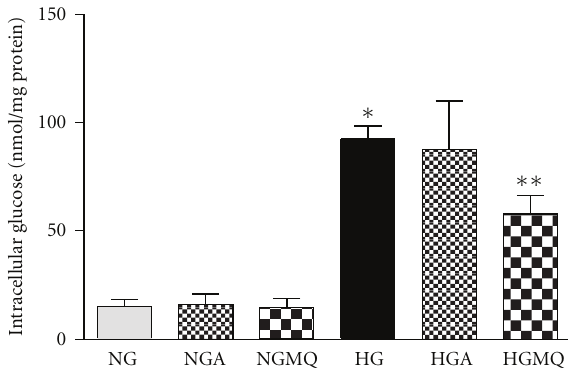
Figure 7: Exposure to high glucose increases intracellular glucose concentration . Subconfluent cells in 24-well plate were exposed to normal glucose (NG, 5.6 mM) and high glucose (HG, 25mM) and in the presence of 500 μ M apocynin (NGA, HGA) or 1 μ M MitoQ (NGMQ, HGMQ) for 4 days. The cells were washed twice with ice-cold PBS, lysed and intracellular glucose concentrations were measured using the Amplex Red glucose assay kit (Molecular Probe). Data are Means ± SEM of 5–14 separate experiments. ∗ P < . 001 versus NG; ∗∗ P < . 05 versus